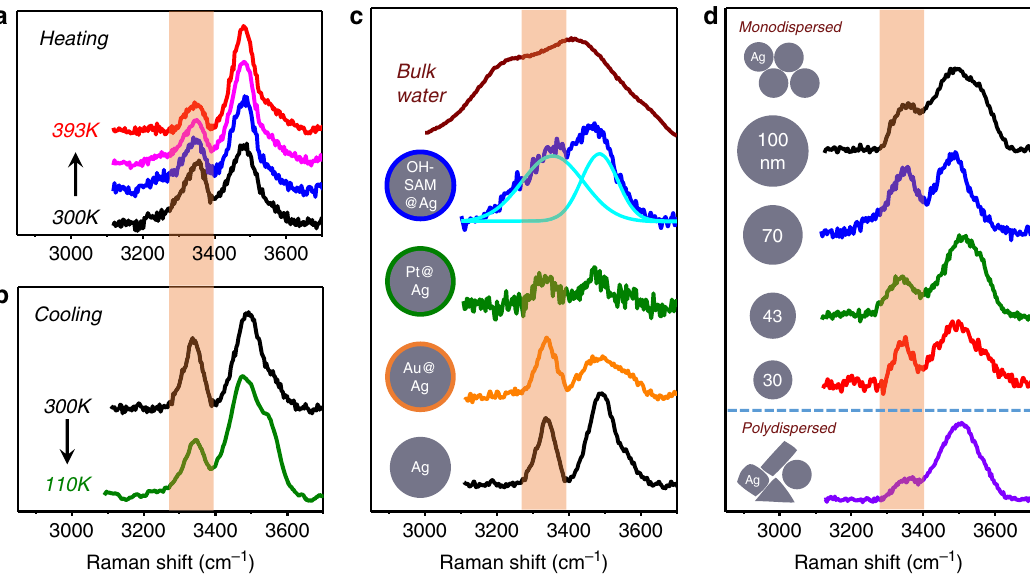
Fig. 3 Generality of ice-VII-like molecular structure. a The DDAA and DA peaks are clearly observed during heating with their spectral widths almost invariant, which con fi rms the persistence of the ice-VII molecular structure for the water nanomeniscus even up to above the normal boiling temperature (393 K). Refer to text for the slight variations of the height of each peak. b The DDAA and DA peaks also show the qualitatively identical features at low temperature of 110 K. The combined results of a and b demonstrate the ice-VII-like molecular structure for the water nanomeniscus over a wide range of temperature. The noticeable change of the height and width of the low-temperature SERS signal is discussed in text. c Different kinds of metallic or nonmetallic surfaces coated on the silver nanoparticles are used to show the generality of the ice-VII-like characters for the water nanomeniscus that can be formed between various surfaces. Presented are the SERS signals for the gold-coated silver (orange curve), platinum-coated silver (green) and OH-SAM (2-mercaptoethanol)-coated silver (blue curve deconvoluted by two cyan curves), as well as the intrinsic silver nanoparticles (black) and the bulk Raman spectrum (brown curve at the top). d Normalized SERS signals demonstrate the similar ice-VII features for the water nanomeniscus, independently of its size, which is demonstrated by using several monodispersed as well as polydispersed nanoparticles (details of sample fabrication and characterization are presented in Supplementary Figs. 10 to